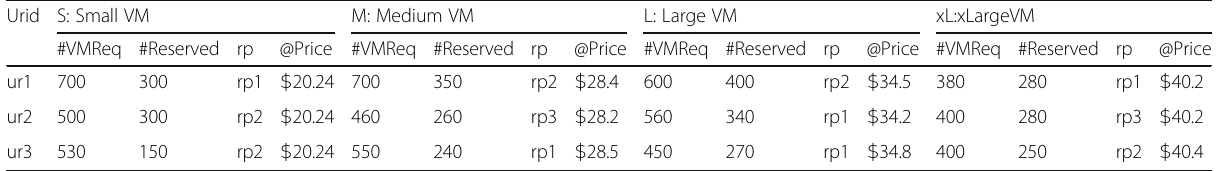
Table 1 A sample of User demands and VM SLA reserved in